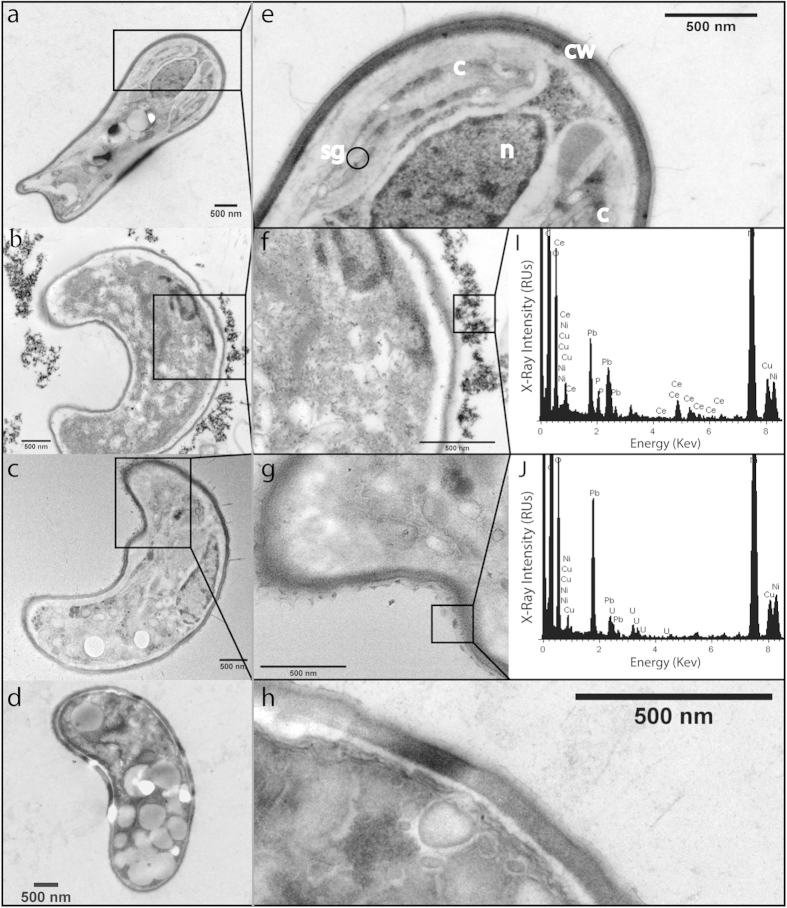
Selected Transmission electron microscopy (TEM) micrographs of P. subcapitata non-exposed (a,e) and exposed to CNP1 (b,f), CNP2 (c,g) and CNP1-PO4−3 (d,h) for 72 h, accompanied with XEDS spectrum (i, j).N = nucleus; C = chloroplast; SG = starch grain; CW = cell wall.